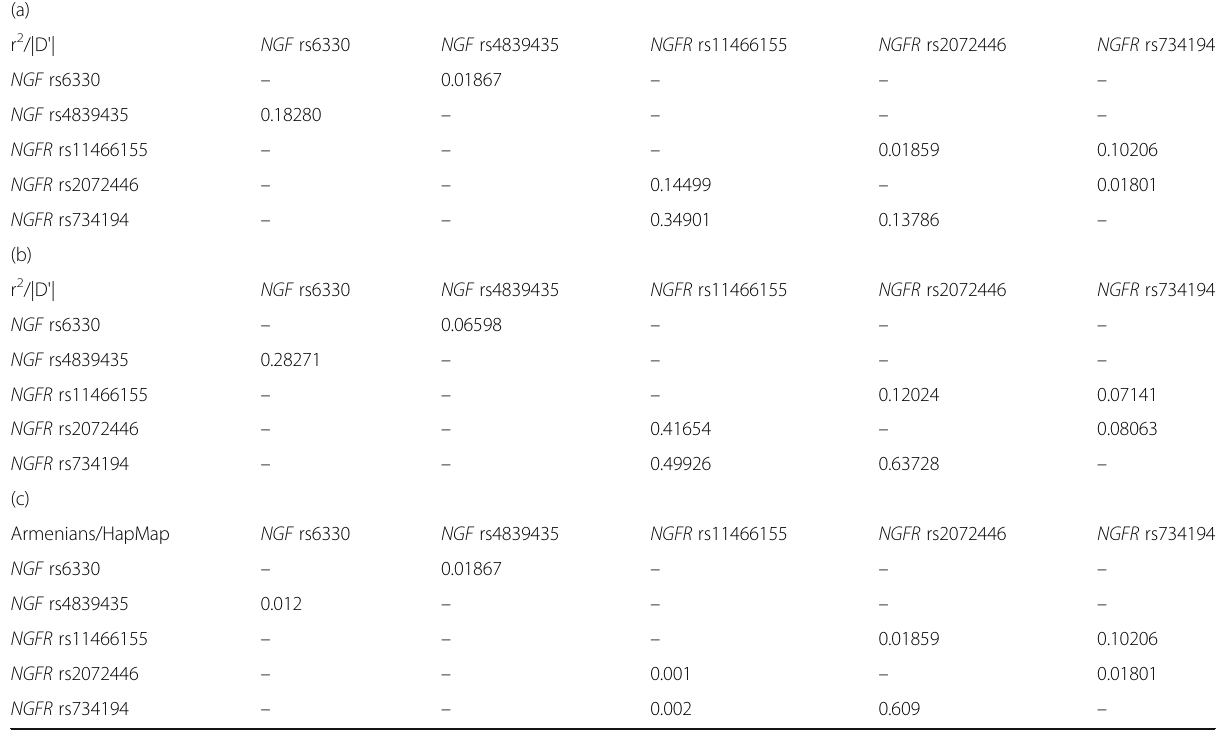
Table 4 LD values (the absolute D ’’ and r 2 ) IS patients (b), and r 2 values calculated from the data obtained for Armenian population involved in this study and for the results available on HapMap (c)